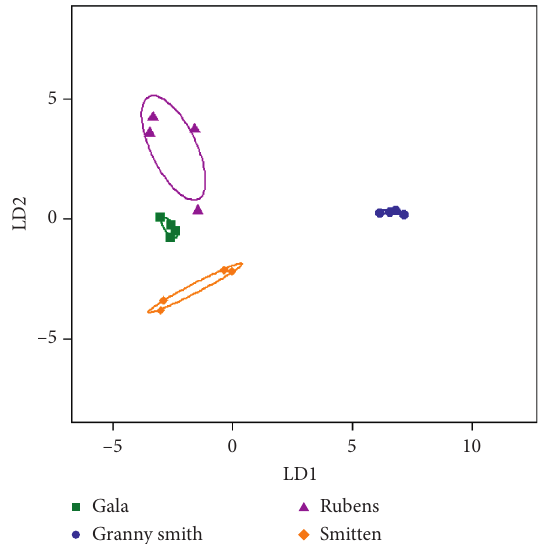
Figure 1: Canonical analysis of principal coordinates based on all apple VOCs using TD-GCxGC-TOF-MS: a CAP model was pro- duced from apple samples of four cultivars. The plot uses the first two linear discriminants (LD); each ellipse represents the 95% confidence interval. Percentage of correct classification of 93.75% ( P < 0 . 01, n � 4). LD1 vs. LD2 accounted for 90.1% of the total variation within